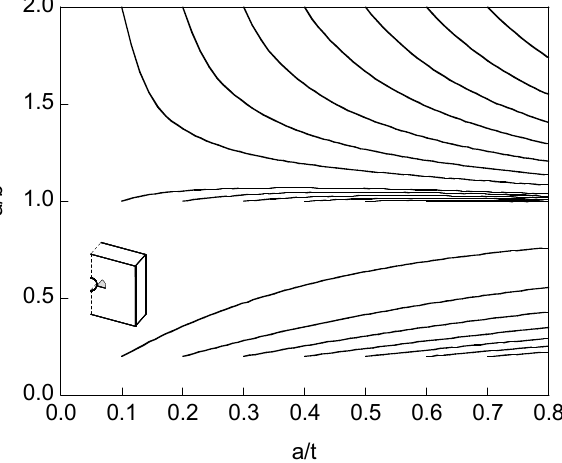
Figure 8. Crack aspect ratio evolution during corrosion fatigue propagation for cracks emanating from a hole with r = 0.5 t .